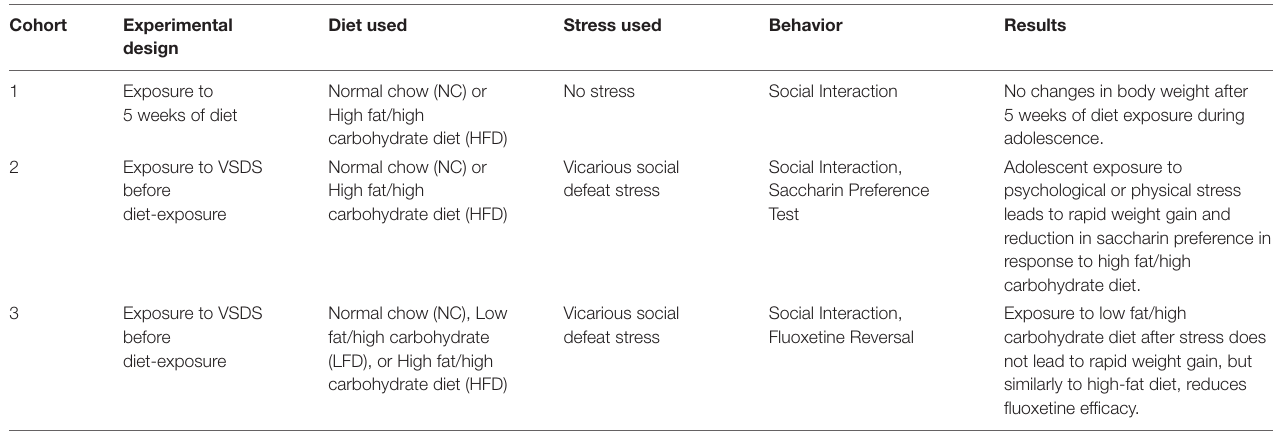
FIGURE 5 | VSDS exposure before WSD during adolescence attenuates response to fluoxetine. (A) To assess the antidepressant efficacy of fluoxetine (FLX) after VSDS and WSD exposure, mice received FLX (80 mg/L) in the drinking water for 21 days ( n = 5/group). (B) Mice in the ES condition that received either LFD or HFD showed an attenuated response to FLX, as the interaction ratio was significantly lower from the mice in the CON + NC condition. Similar effects of attenuated FLX response were seen for the mice in the PS condition regardless of diet exposure (main effect; diet p < 0.01 and stress p < 0.0001). Data are shown as mean ± SEM. ∗ p < 0.05 ** p < 0.01. TABLE 1 | Breakdown of experimental design and the results have been summarized